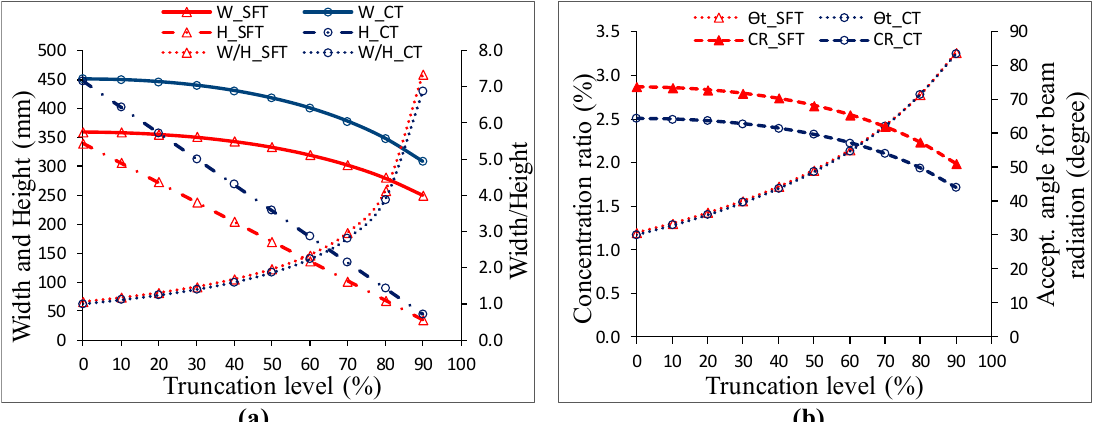
Figure 5. E ff ect of reflector truncation on: ( a ) aperture width, reflector height and width / height ratio; ( b ) CR and acceptance angle for beam radiation ( θ t ).